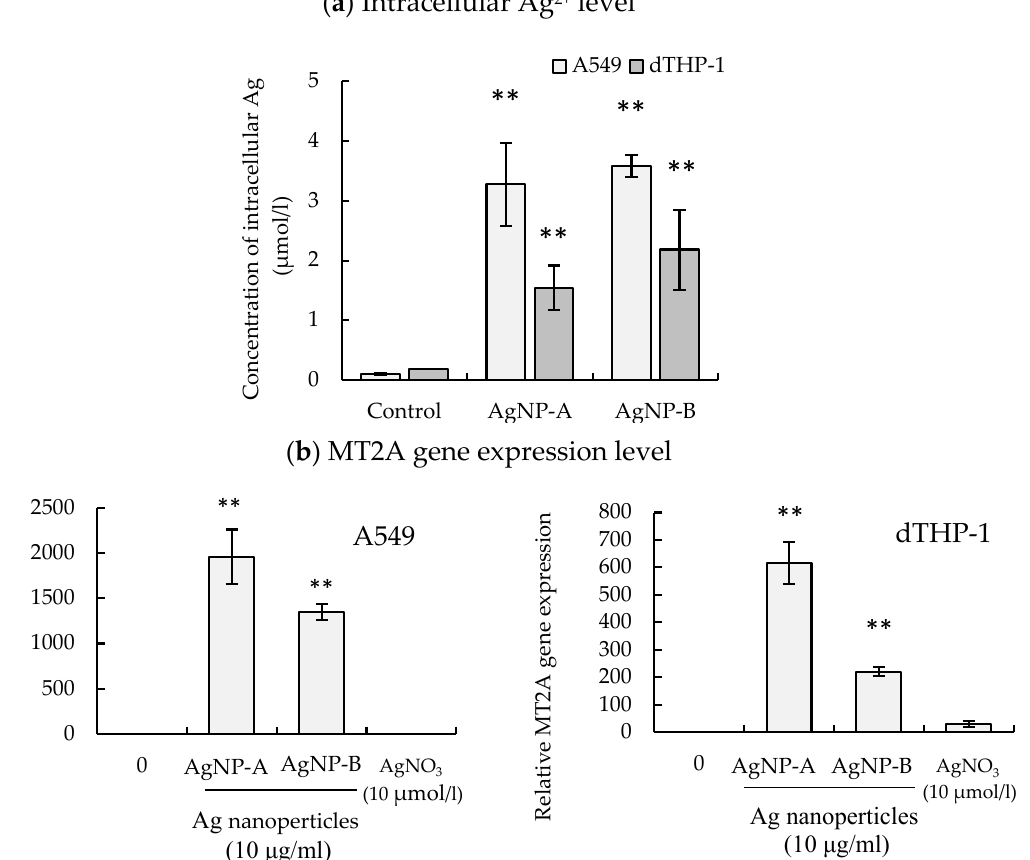
Figure 2. Effects of AgNPs on intracellular silver level. ( a ) intracellular silver concentration in silver nanoparticle-exposed cells. A549 and dTHP-1 cells were exposed by silver nanoparticle suspensions for 24 h at concentration of 10 μ g/mL. Intracellular silver ion levels were determined by ICP-MS. ( b ) Effect of silver nanoparticles and AgNO 3 on MT2A gene expression. A549 and dTHP-1 cells were exposed by silver nanoparticle suspensions for 24 h at concentration of 10 μ g/mL. AgNO 3 was ad- ministered at 10 μ mol/L. MT2A gene expression levels were determined by real time-PCR. The MT2A gene expression in standardized untreated cells was 1. ** p < 0.01 (vs. unexposed cells, ANOVA and Dunnett’s test) .